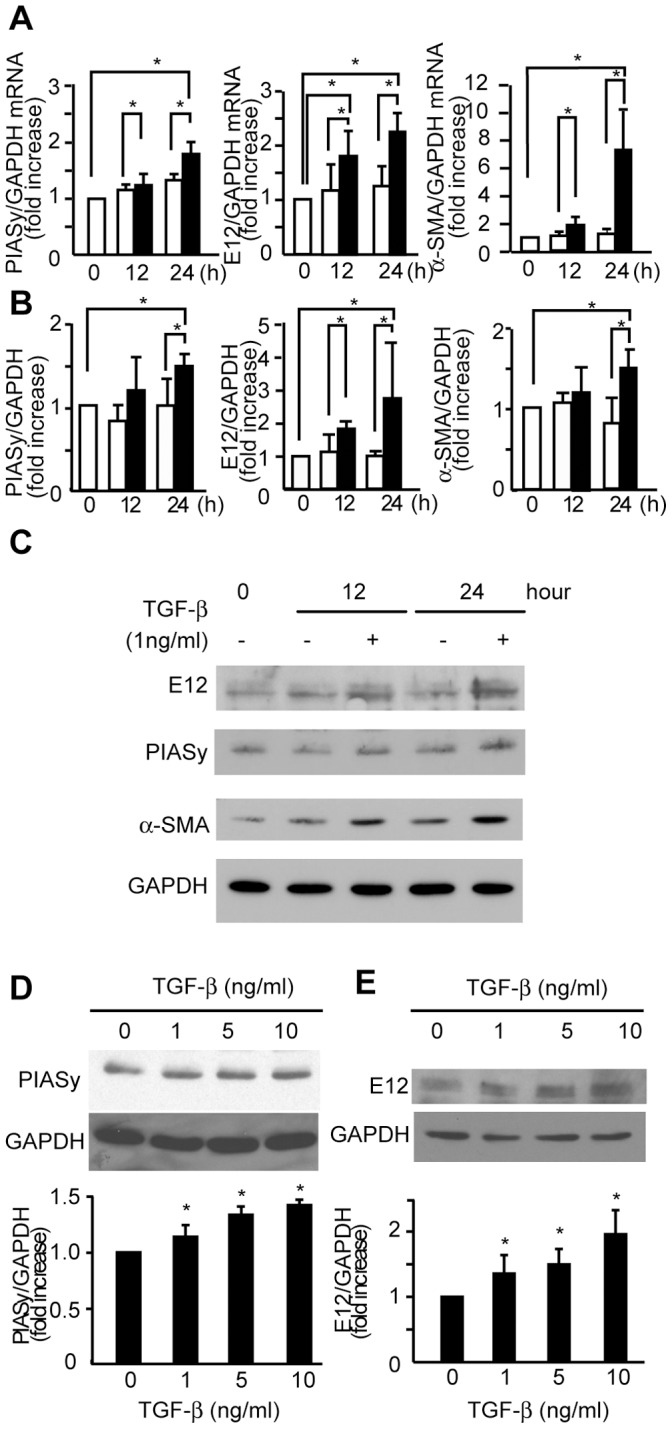
TGF-β increased PIASy, E12, and α-SMA mRNA and proteins in MCs.
(A) Mouse MCs were cultured in the presence or absence of 1 ng/ml TGF-β for the indicated times. Gene expression of PIASy, E12 and α-SMA was examined by quantitative RT-PCR using mRNA of MCs treated or untreated with TGF-β. Means of four independent experiments are shown. The results are presented as the fold-increase or decrease compared with the values of 0 hours. Open bars denote no treatment, closed bars TGF-β treatment. (C) Mouse MCs were cultured in the presence or absence of 1 ng/ml TGF-β for the indicated times. Total cell lysates were examined by Western blot analysis using anti-PIASy, anti-E12, and anti-α-SMA antibodies. Representative data from four independent experiments is shown. (B) Optical densitometry of PIASy, E12 and α-SMA in Western blotting. The values of PIASy, E12 and α-SMA were normalized for that of GAPDH and compared with the values of 0 hours. Means of four independent experiments are shown. Open bars denote no treatment, closed bars TGF-β treatment. (D) TGF-β increased PIASy proteins in MCs in a dose-dependent manner. Mouse MCs were cultured with the indicated doses of TGF-β for 24 hours. (E) TGF-β increased E12 proteins in mesangial cells in a dose-dependent manner. Mouse MCs were cultured with the indicated doses of TGF-β for 24 hours. The values of PIASy and E12 were normalized for that of GAPDH and compared with the values of control vehicle. Means of four independent experiments are shown. *P<0.05, v.s. control.